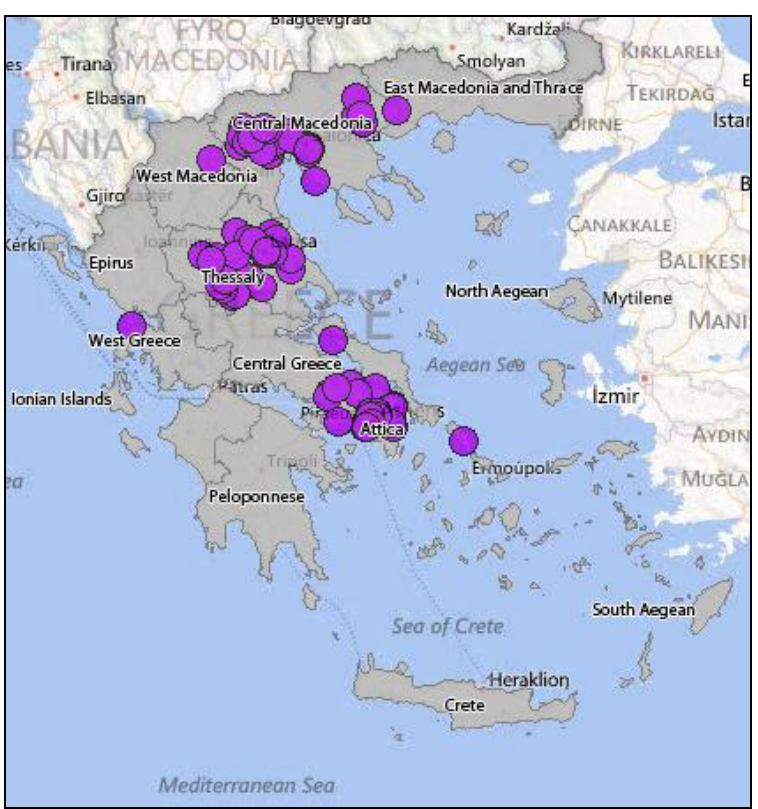
Figure 7. WNV human cases in Greece,